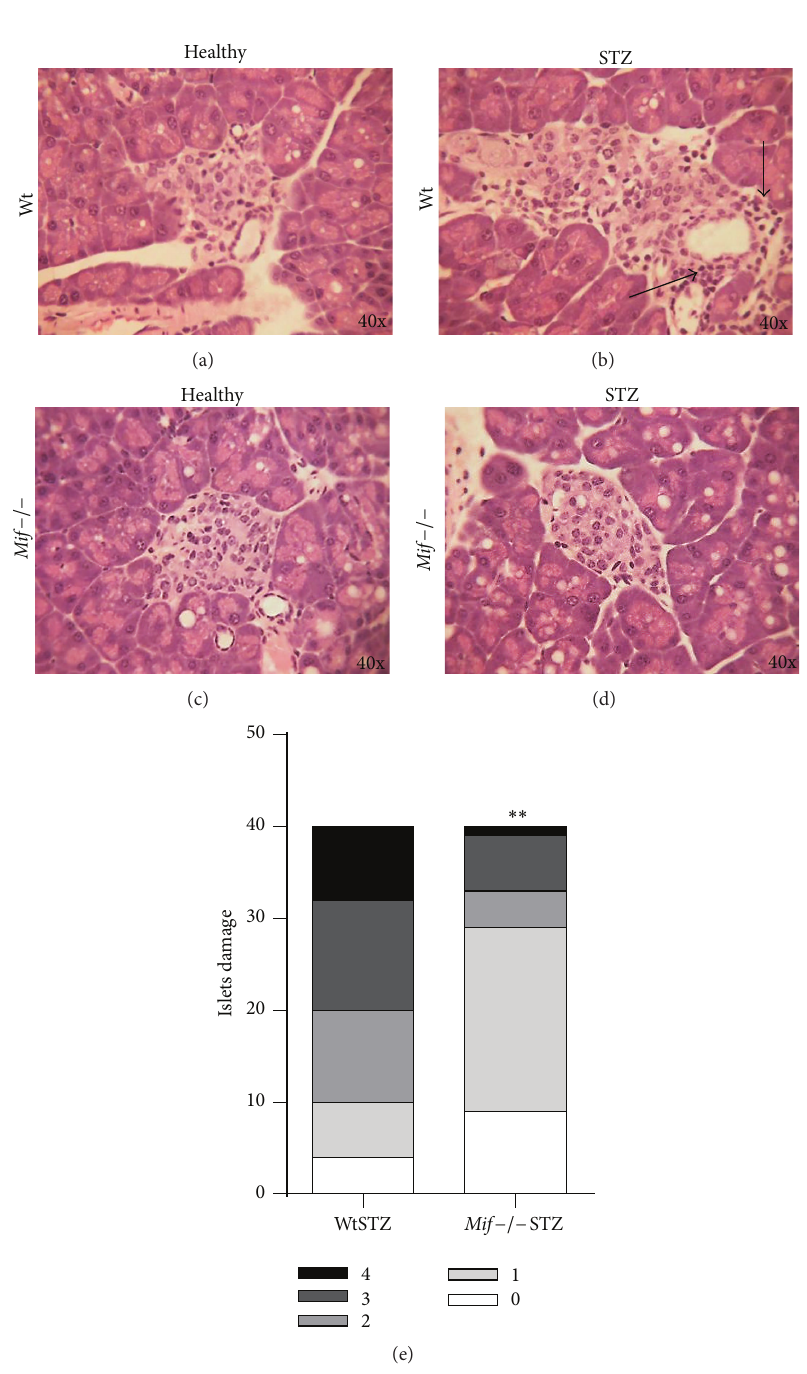
Figure 3: Mif − / − mice conserve their healthy anatomy and exhibit limited cellular infiltration into pancreatic islets after STZ administration. Pancreases isolated from Wt or Mif − / − mice were examined via histological analysis of eosin-hematoxylin (E&H) staining to establish the number of pancreatic islets and to determine lymphocyte infiltration (arrowhead in (b)) at 8 weeks after STZ administration. Pancreatic islets from healthy Wt mice (a); Wt mice treated with STZ, WtSTZ (b); healthy Mif − / − mice (c), and Mif − / − mice treated with STZ, Mif − / − STZ (d). Compilation of infiltration stages in the pancreas of Wt and Mif − / − mice after STZ administration (e). Pancreatic islets were scored using the following scale: grade 0 (no insulitis) = 0% infiltration; grade 1 (peri-insulitis) = 1–10% infiltration; grade 2 (moderate insulitis) = 11– < 50% infiltration; grade 3 (severe insulitis) = > 50% infiltration; or grade 4 (complete insulitis) = complete infiltration. We counted